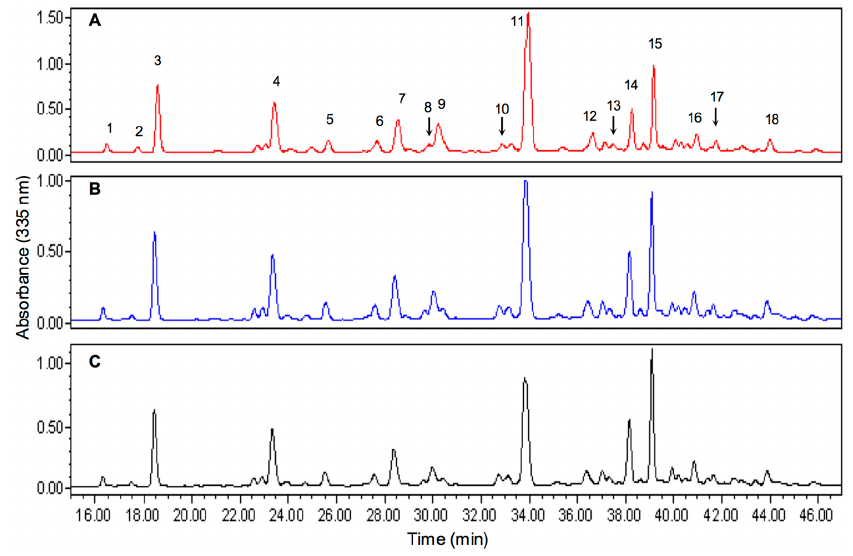
Figure 3. HPLC-PDA chromatograms (335 nm) of flavonoids present in thyme ( Thymus vulgaris L.).